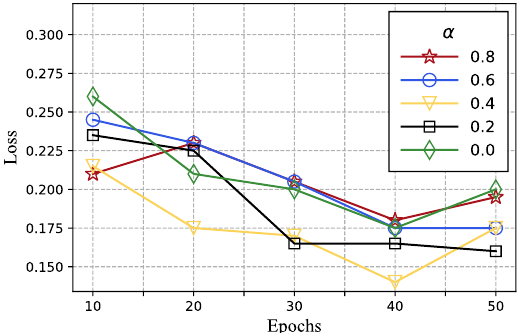
Figure 6. The changing trend of the expression loss rate.